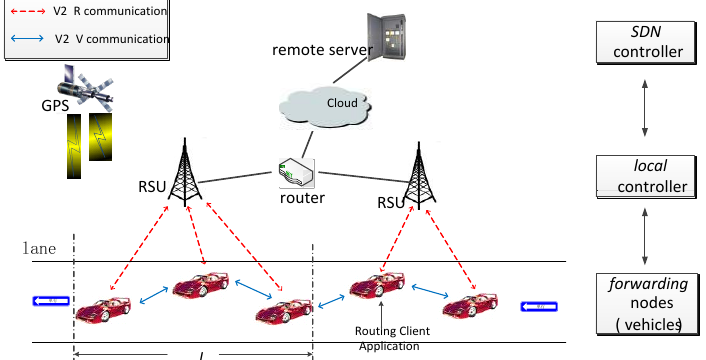
Figure 1. The architecture of software-defined network (SDN)-based routing framework.